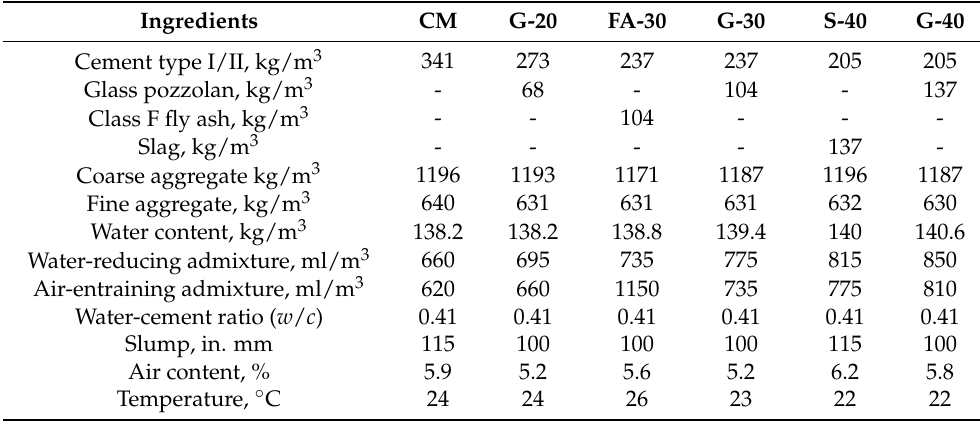
Table 3. Mix designs of concretes.